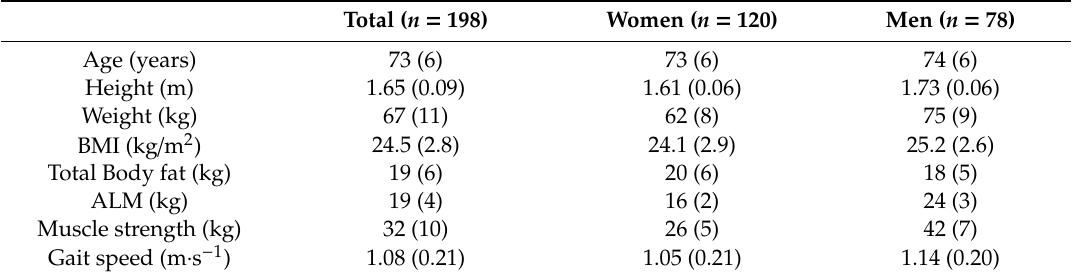
Table 1. Descriptive statistics of the study population represented as mean ( ± standard